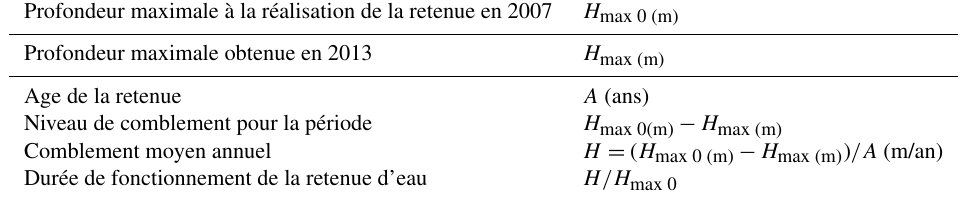
Tableau 1. Paramètres d’estimation du comblement de la cuvette.